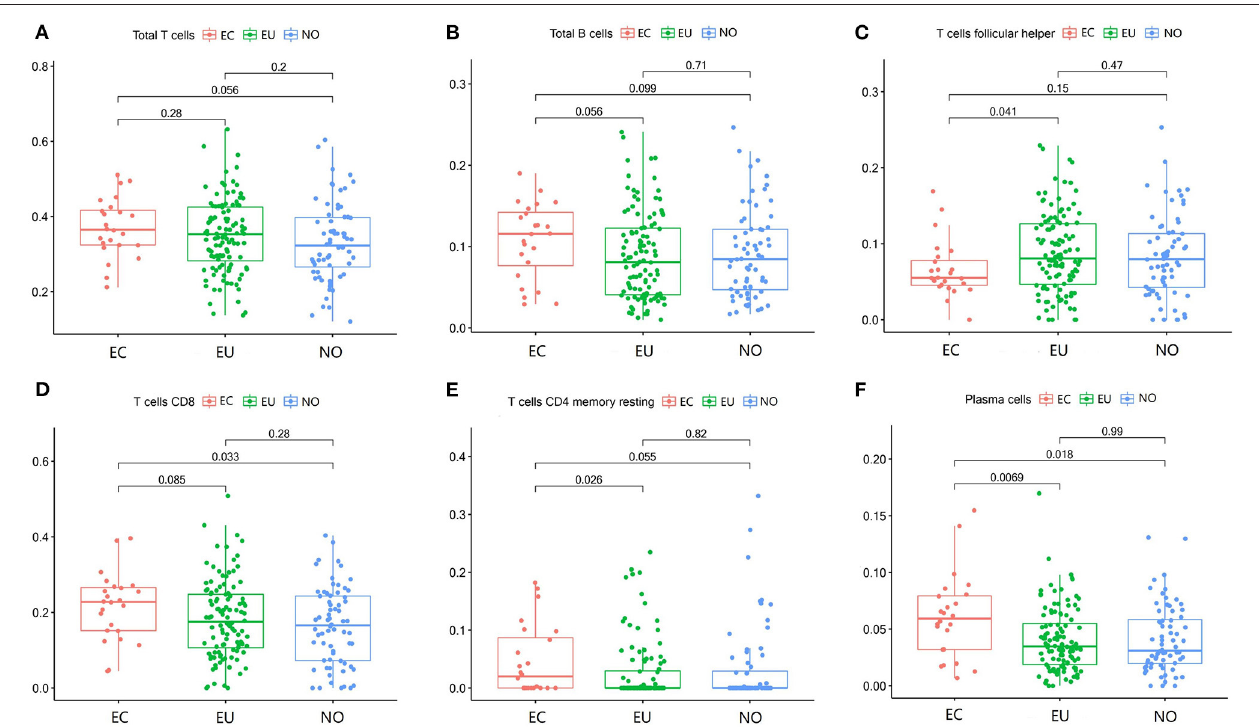
FIGURE 1 | T cells and B cells in EC, EU, and NO. CIBERSORT immune cell fractions were determined for each patient; each dot represents one patient. The upper quartile (P25), median value, lower quartile (P75) after removing datas with large deviation for each cell subset, including total T cells (A) , total B cells (B) , and follicular